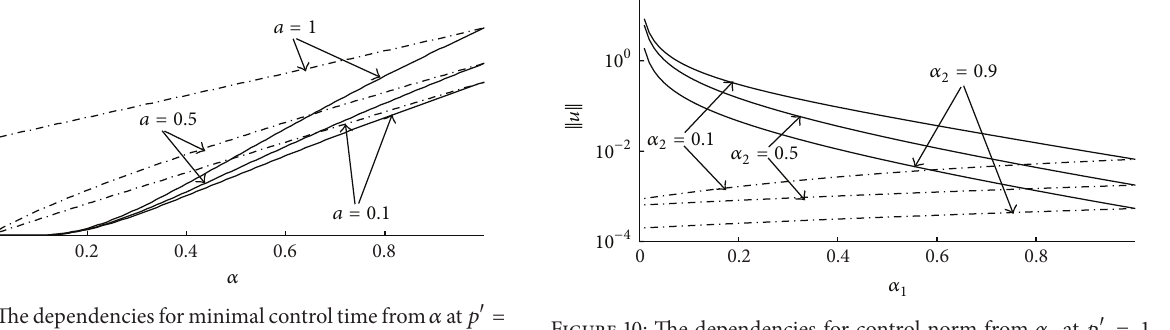
Figure 10: The dependencies for control norm from 𝛼 1 at 𝑝 󸀠 = 1 and several values of 𝛼 2 .